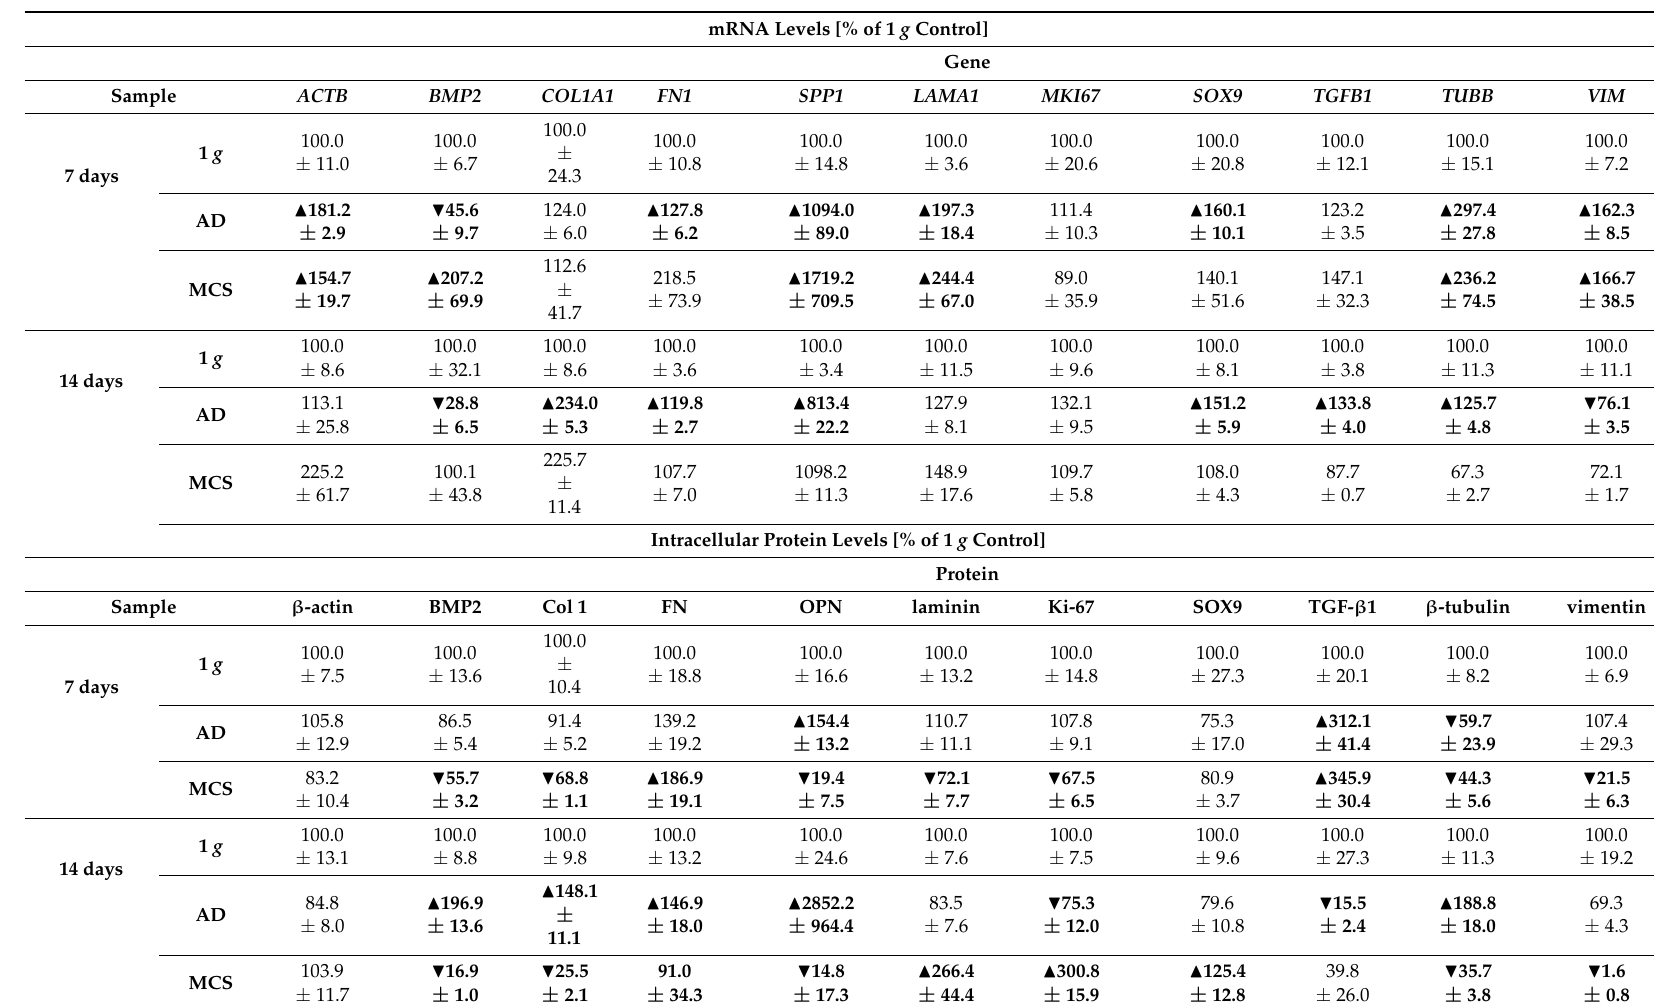
Table 1. Changes in gene expression, protein levels and secretion